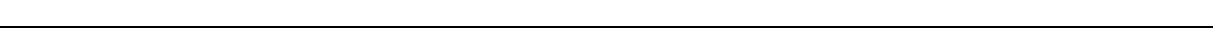
Fig. 3 Graft-derived laminae I-II domains are preferentially innervated by regenerating host CGRP + axons. Images of ( a , b , d ) cervical spinal cord from intact, age-matched rats and ( c , f – h ) spinal cord NPC grafts at 6 weeks post-transplantation. a Primary afferent CGRP + axons (cyan) terminate within the super fi cial dorsal horn of the intact C4 spinal cord. b Termination of CGRP + axons (cyan) overlaps substantially with the laminae I – II band of calretinin (Calr, red) immunoreactivity in the intact C4 dorsal horn. Dotted line indicates border of calretinin + immunoreactivity. c Host CGRP + fi bers (cyan) penetrate spinal cord NPC grafts and densely innervate graft-derived calretinin + clusters (red). Graft/host border indicated with dotted line. d Sagittal images of cervical dorsal horn of uninjured animals sacri fi ced 90 min after subcutaneous injection of either vehicle (VEH) or capsaicin (CAP) into the forearms. c - Fos immunoreactivity is abundant in nuclei of cells within the laminae I – II calretinin + band (red) in capsaicin-treated animals (CGRP, blue). Inset: High-magni fi cation image of dorsal horn laminae I – II in capsaicin-treated animals reveals c-Fos immunoreactivity (green) in nuclei of calretinin + neurons (red; arrowhead); CGRP, blue. e Quanti fi cation of the number of c-Fos + nuclei per mm 3 volume within the laminae I-II calretinin + band of intact cervical spinal cord following 90 min treatment with either vehicle ( n = 3) or capsaicin ( n = 3). Mean ± SEM; *** p < 0.001 by two-tailed t -test. f , g Images of NPC grafts from animals receiving subcutaneous injections into the forelimbs of either ( f ) vehicle or ( g ) capsaicin 90 min prior to sacri fi ce, showing c- Fos (green), calretinin (red), and CGRP (blue) immunoreactivity. f ’ , g ’ High-magni fi cation images of grafts. f ’ In a graft from a vehicle-treated animal, a few c-Fos + nuclei (green) are present within a calretinin + neuron (red) patch heavily innervated by host CGRP + axons (blue). g ’ In a graft from a capsaicin- treated animal, many c-Fos + nuclei (green) are present within a calretinin + neuron (red) patch with modest innervation by host CGRP + axons (blue). h Quanti fi cation of the number of c-Fos + nuclei per mm 3 volume within calretinin + graft domains with CGRP + axon innervation (solid), and calretinin + graft domains without CGRP + axon innervation (diagonal stripes) at 90 min after subcutaneous injection with either vehicle (gray; n = 3) or capsaicin (red; n = 3). Mean ± SEM; ** p < 0.01 by two-tailed t-test (Veh vs. Cap treatment was compared for either CGRP + or CGRP-negative clusters). Scale bars = 100 μ